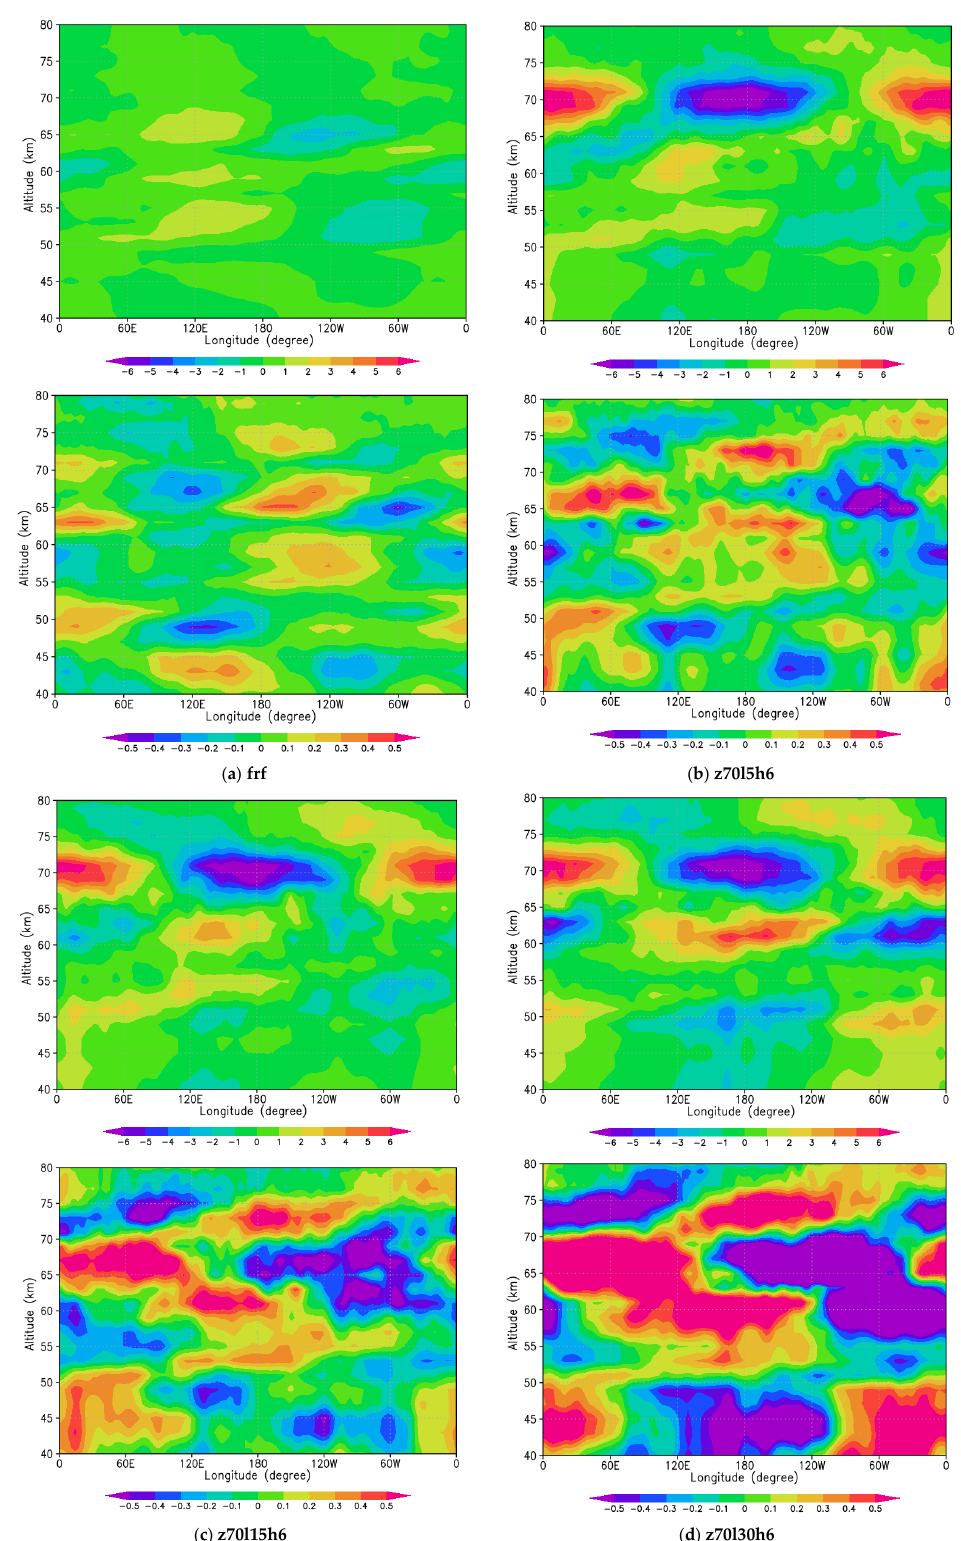
Figure 6. Composite means of zonal wind (top panels) and temperature (bottom panels) in longitude-altitude sections at the equator obtained for ( a ) frf, namely, free run forecast of AFES-Venus, and the cases of ( b ) z70l5h6, ( c ) z70l15h6 and ( d ) z70l30h6 (analysis). The total number of successive data used for composite means is 85, with every data arranged equally in order to extract the equatorial Kelvin-type waves with about 4-day